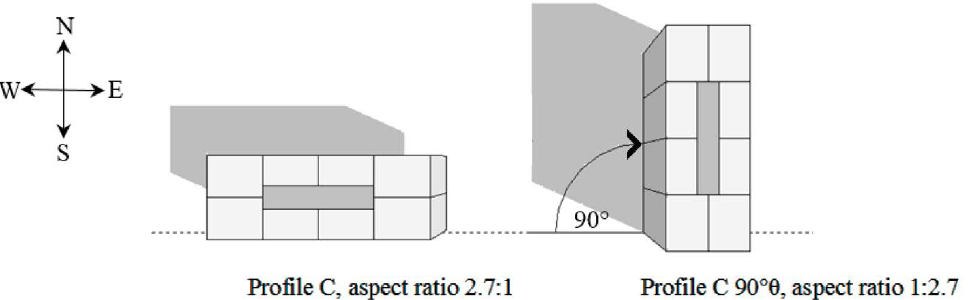
Figure 8. A 90° rotation of building models along the axis inverts the aspect ratio when defined with x,y coordinates.